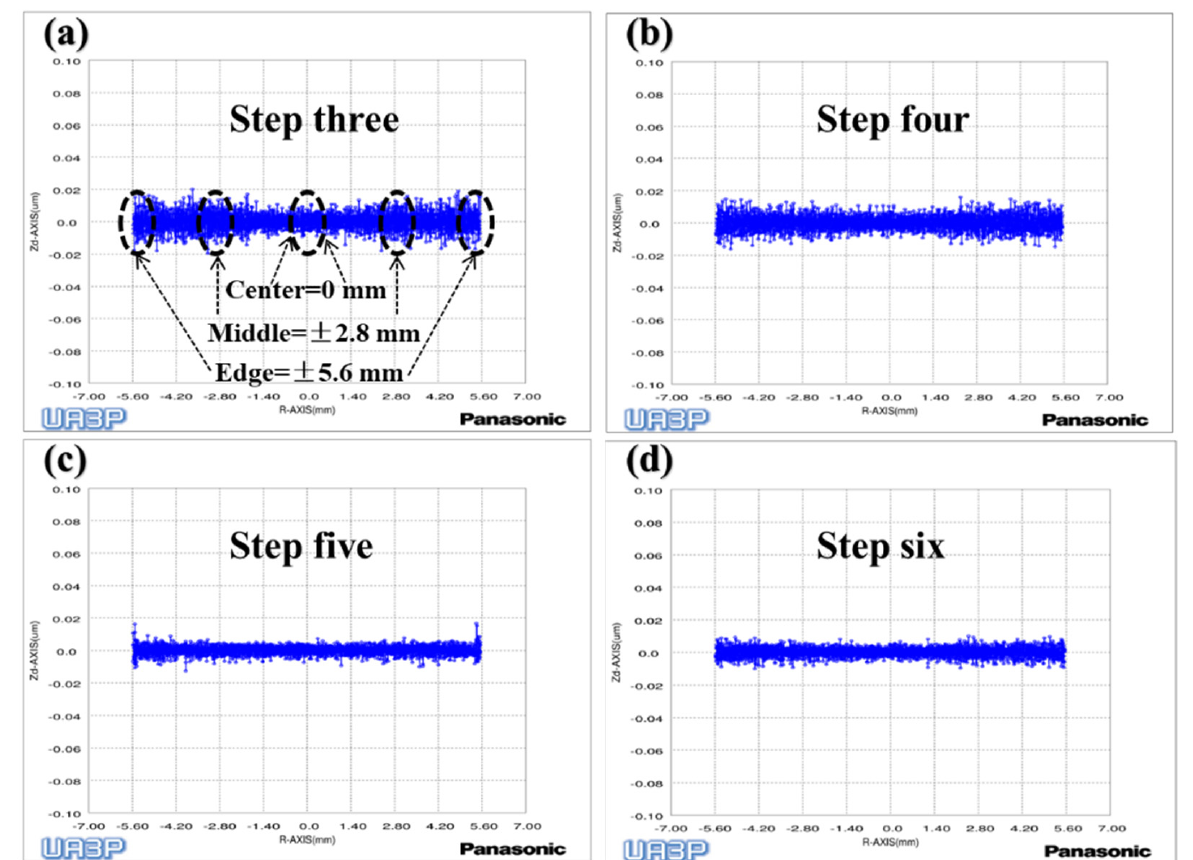
Figure 15. Process of SR distribution change of aspherical mold one: ( a ) Polishing with constant rotation speed mode; ( b ) Polishing with variable speed mode; ( c ) Polishing with small polishing disc tool; ( d ) Polishing with variable speed mode.